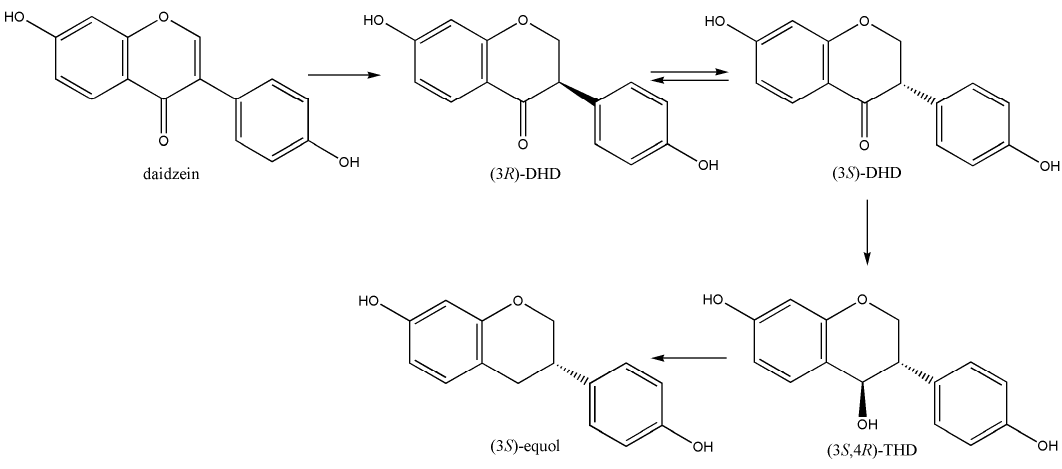
Figure 3. Stereospecific S -equol biosynthetic pathway.